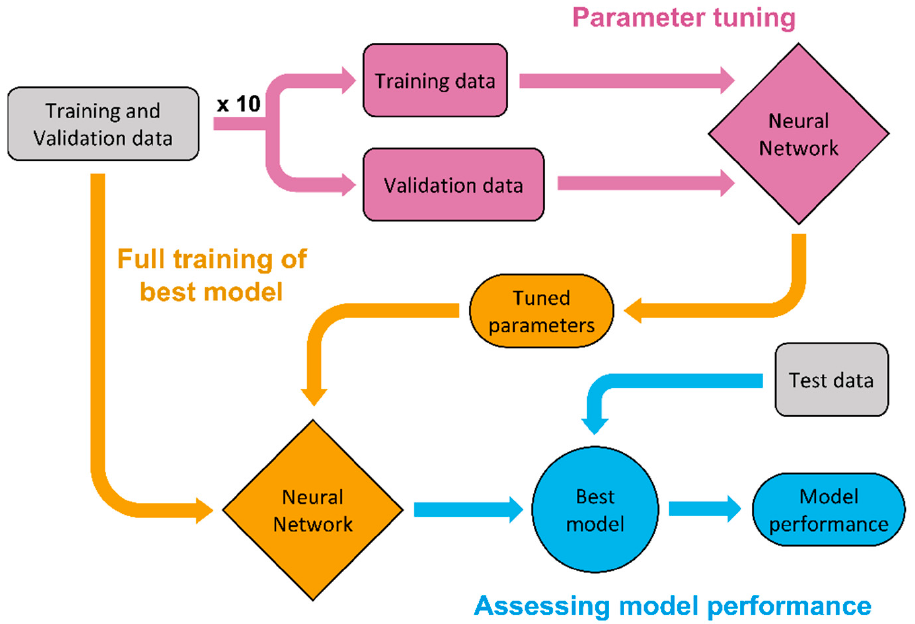
Figure 2. Schematic representation of the machine learning workflow adopted. The data for the parameter tuning were divided into 10 sets of training and validation datasets, allowing cross-validation of the models evaluated and then fed to the neural network algorithm. The algorithm returns the performance of the models on the validation sets, which is the basis for selecting the tuned parameters that allowed best performance for the model. The model is trained on a joint dataset (train + validation) to obtain the best performing model. The performance of the best model is assessed using a test dataset, unseen during the previous phases of the workflow. Table 3. Crucial parameters of the neural network algorithm, definitions, and values